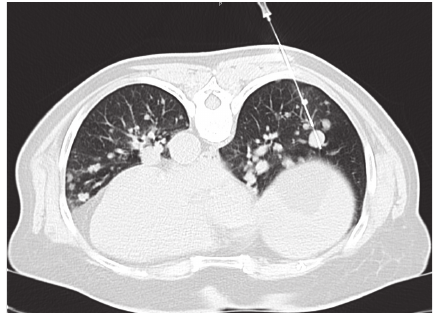
Figure 5: CT-guided needle biopsy of pulmonary metastasis of splenic angiosarcoma (20 G Trucut needle).